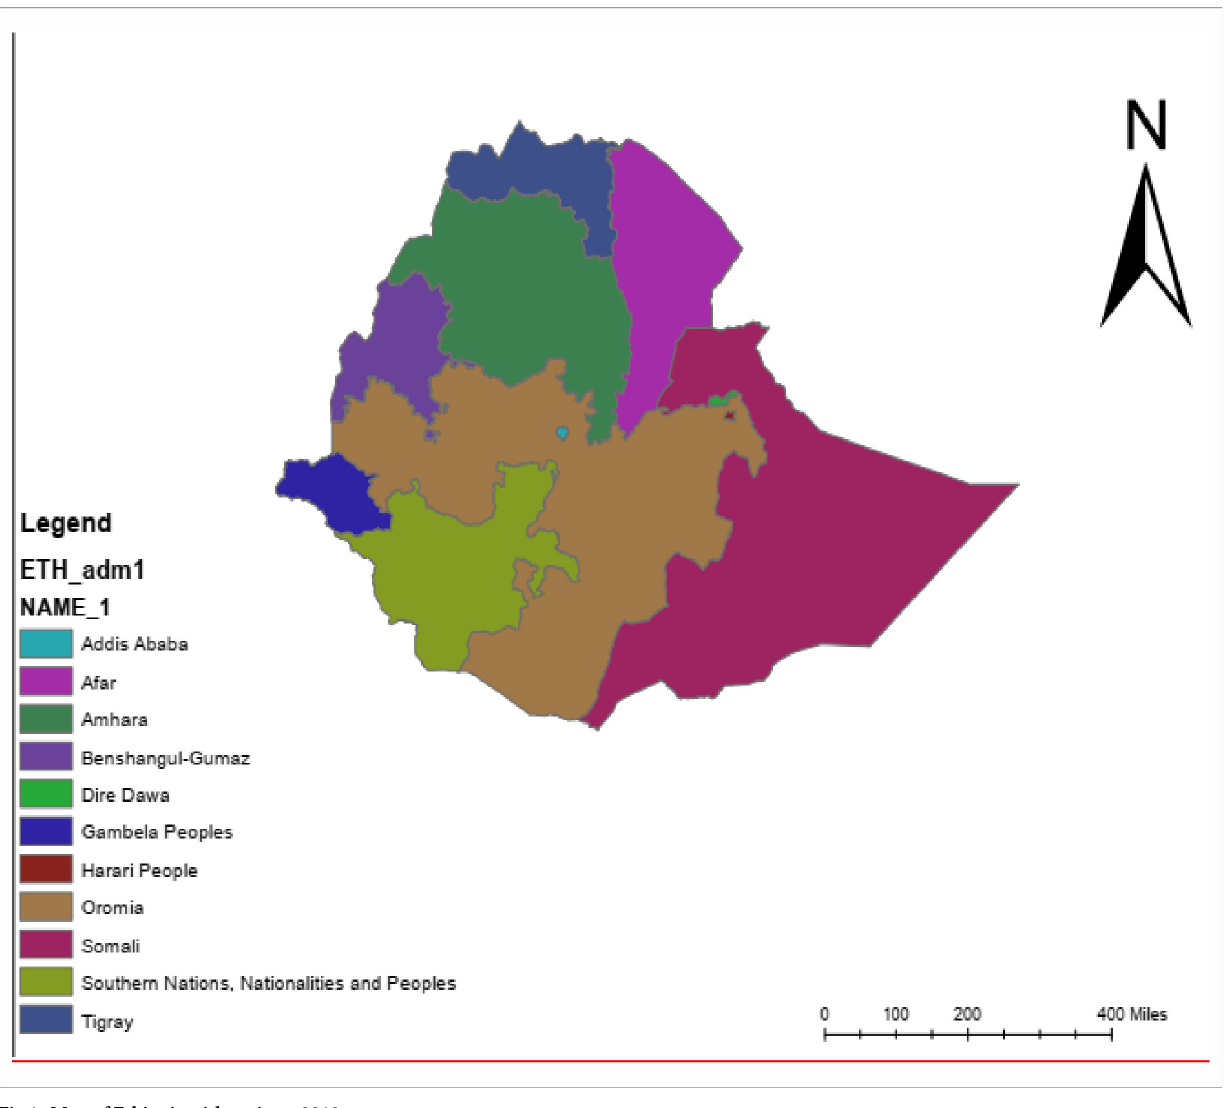
Fig 1. Map of Ethiopia with regions,